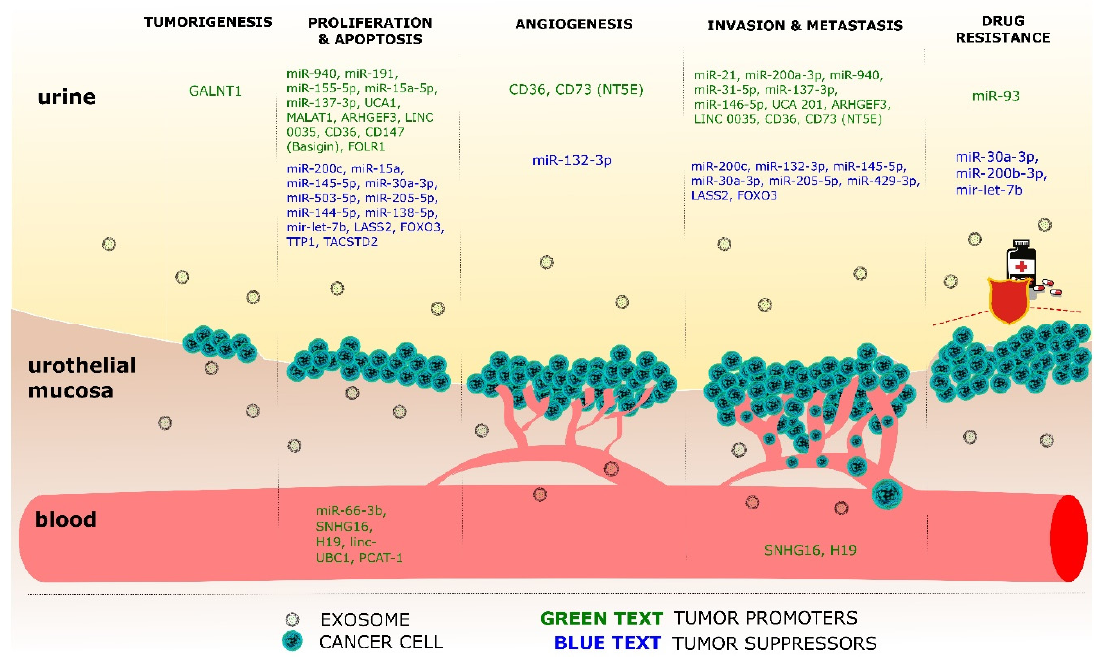
Figure 1. Extracellular vesicles (EV) biomarker isolation in urine and blood and their role in different stages of bladder cancer (BC) tumorigenesis.